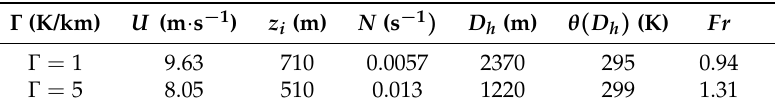
Table 2. The values of U , z i , D h , θ ( D h ) , N and Fr